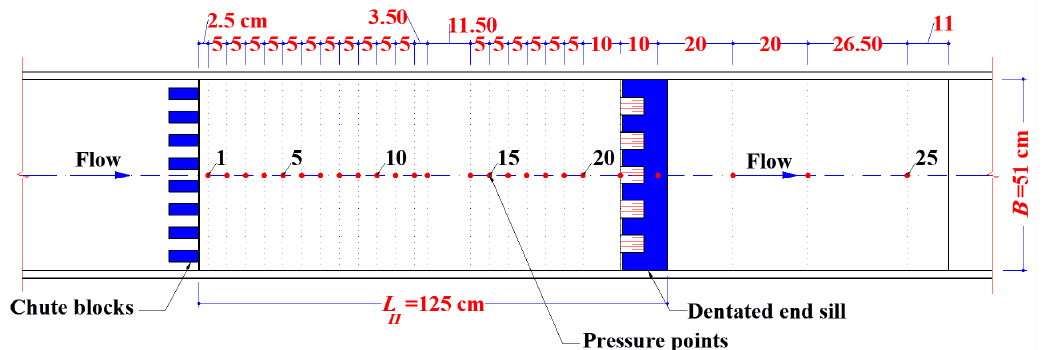
Figure 3. Distribution of the pressure points at the centerline of the apron along basin II .